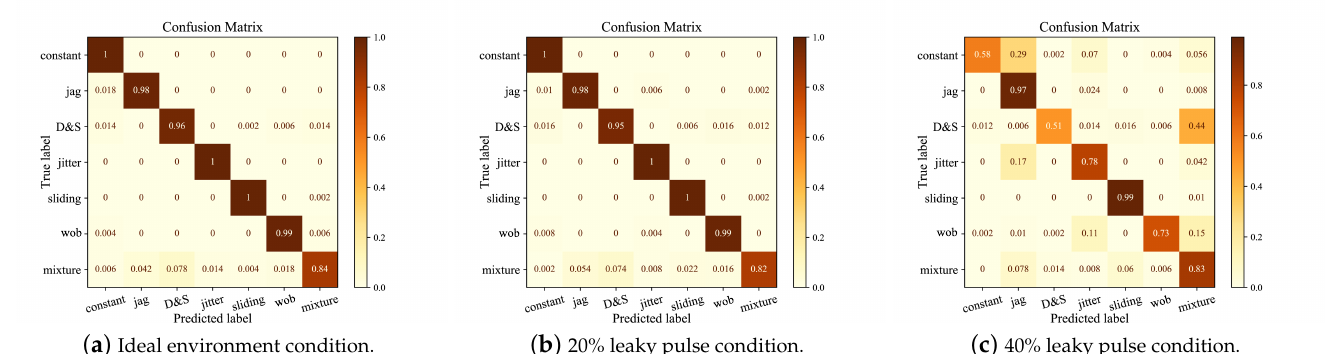
Figure 10. ResNet24-1D modulation mode recognition confusion